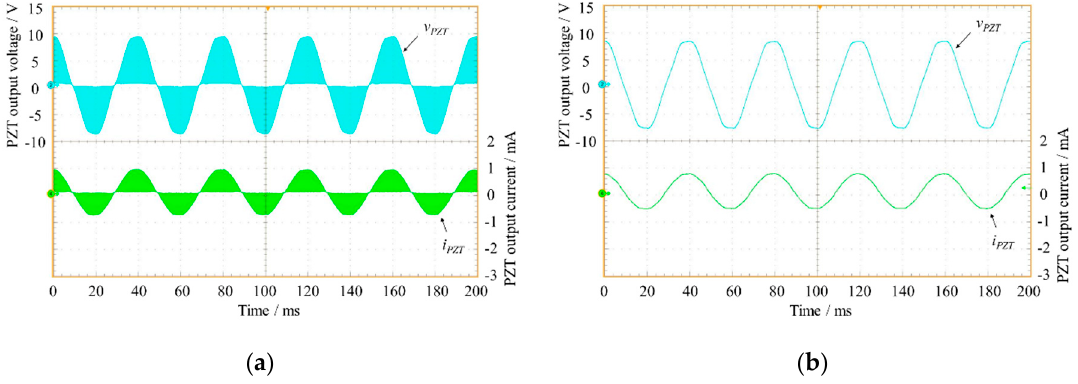
Figure 11. ( a ) Plots of output voltage v PZT (in cyan) and output current i PZT (in green) versus time and ( b ) filtered signals of the output voltage v PZT (in cyan) and of the output current i PZT (in green).